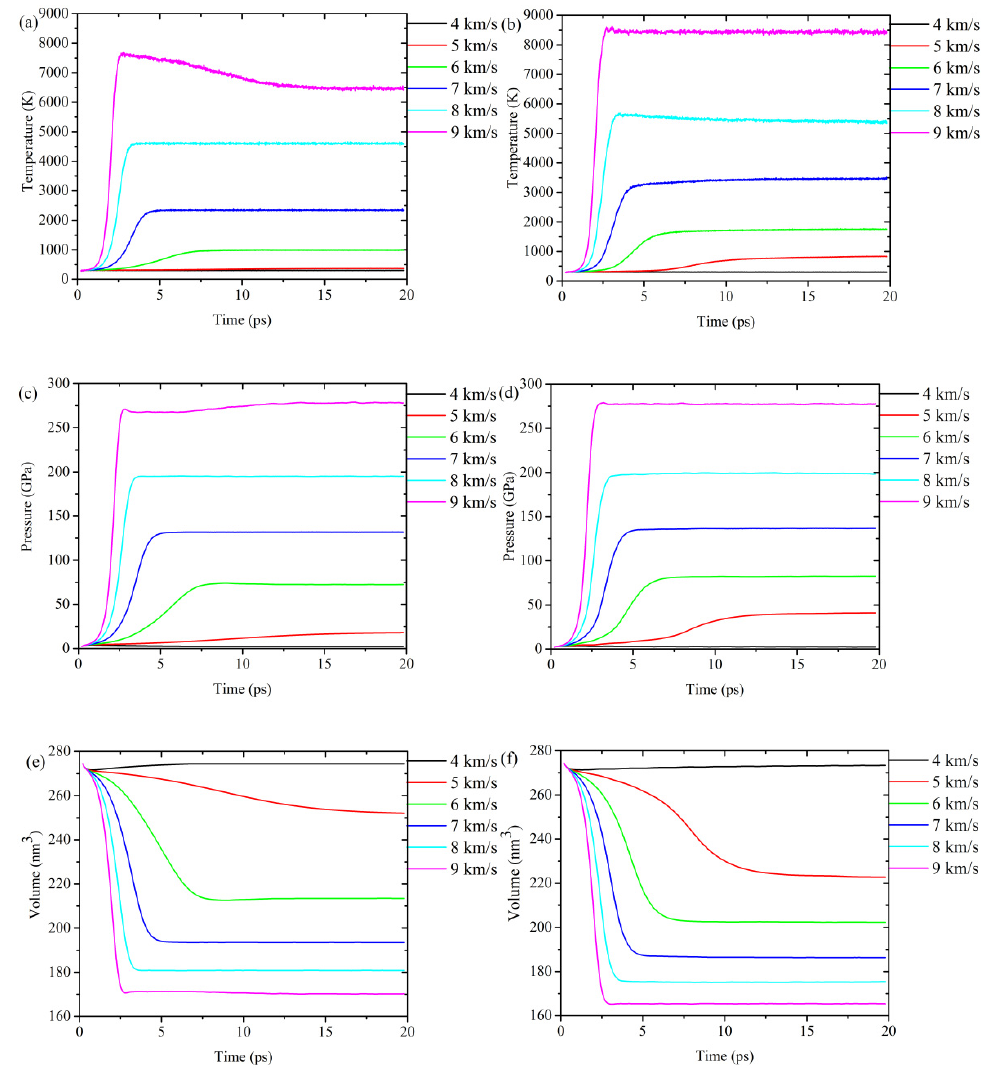
Figure 3. Time evolution of the thermodynamic parameters of the two systems with different shock wave velocities. ( a , c , e ) correspond to the voids-free system and ( b , d , f ) correspond to the nanovoid-containing system.